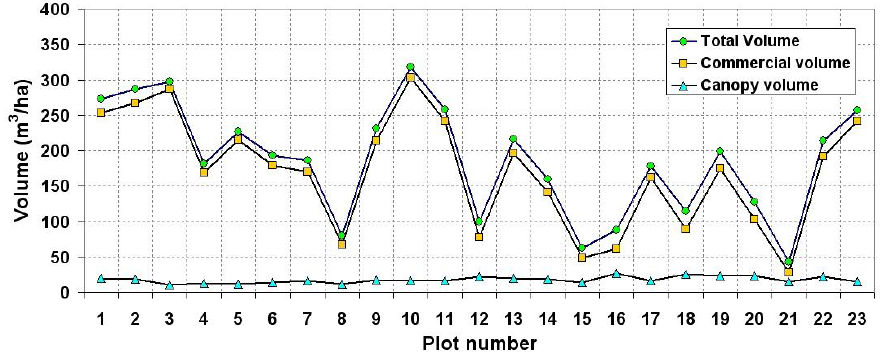
Figure 5. Total, Commercial and Canopy mean